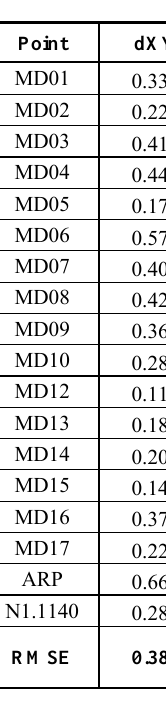
Table 4. Independent Check Points Result